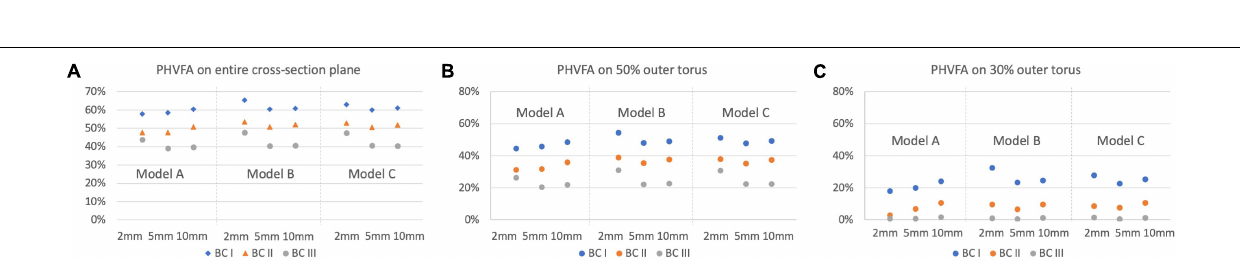
Frontiers in Physiology |